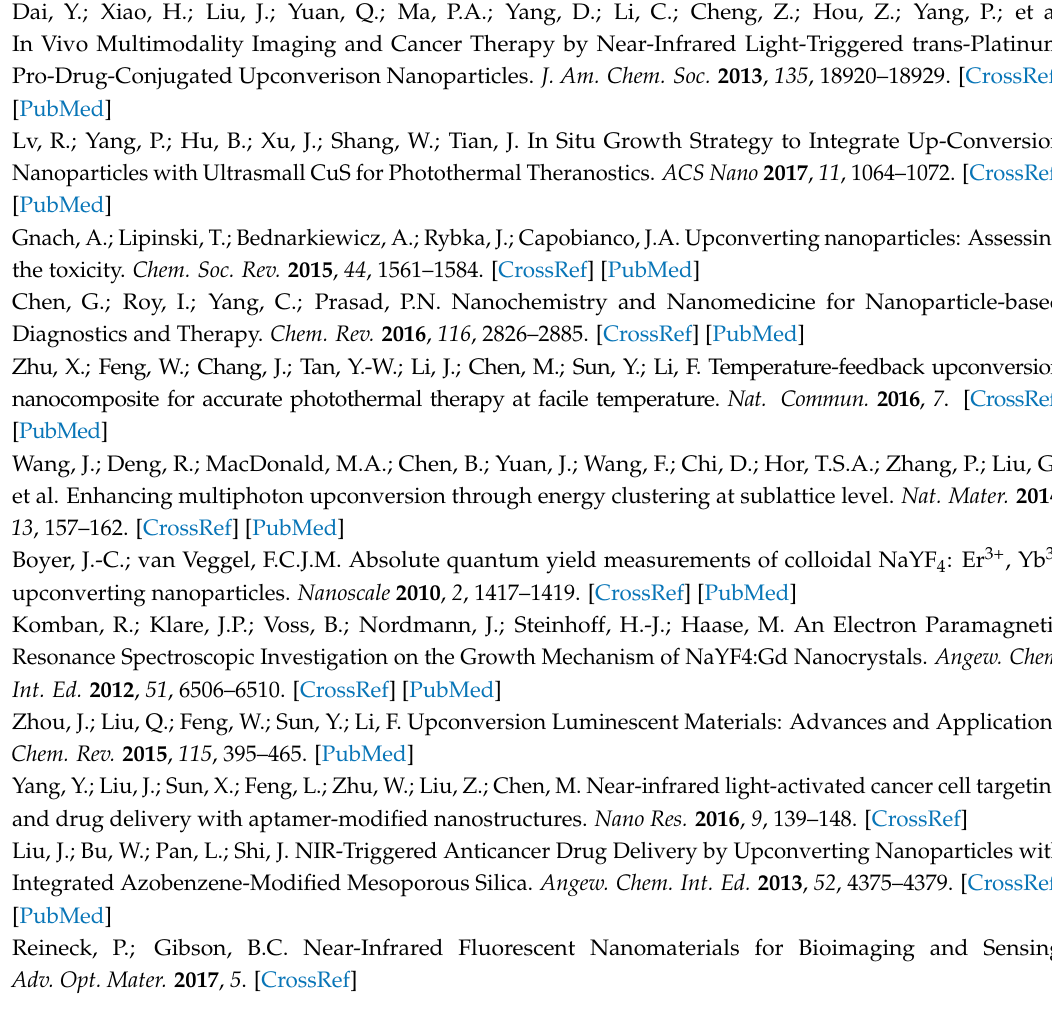
Table S1: The refractive index n of NaYF 4 in dependence of the wavelength; Table S2: The refractive index n of SiO 2 ; Table S3: The refractive index n of Au, Figure S1: The refractive index n (real part) of NaYF 4 , SiO 2 , and Au. Author Contributions: All authors have given approval to the final version of the manuscript. Conceptualization, R.L.; Experiment, R.L. and M.F.; Data Curation, R.L.; Validation, W.J.P.; Writing-Original Draft Preparation, R.L.; Writing-Review & Editing,